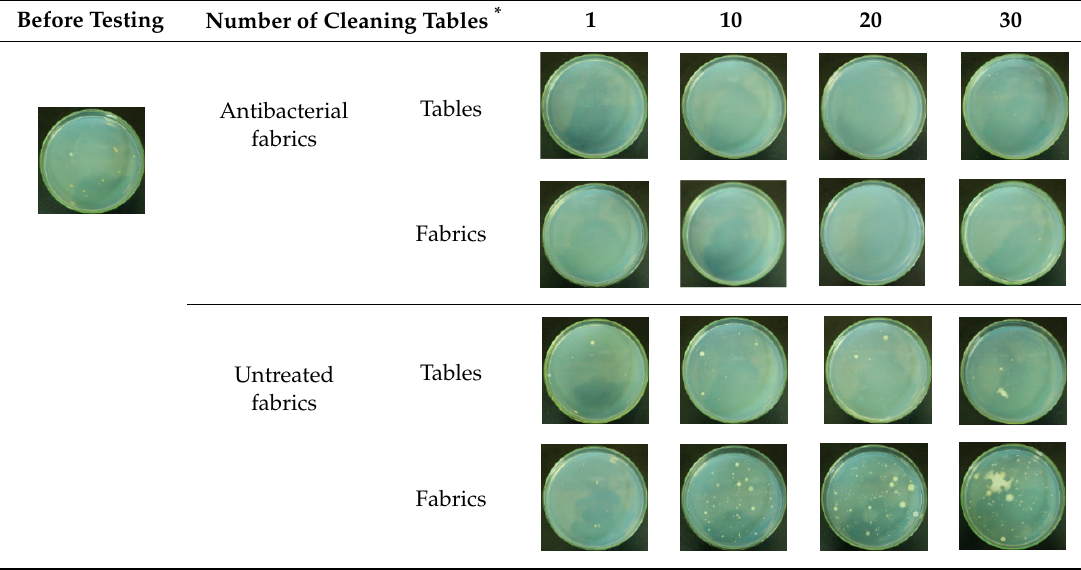
Table 1. The antibacterial qualitative testing results of chlorinated fabrics.